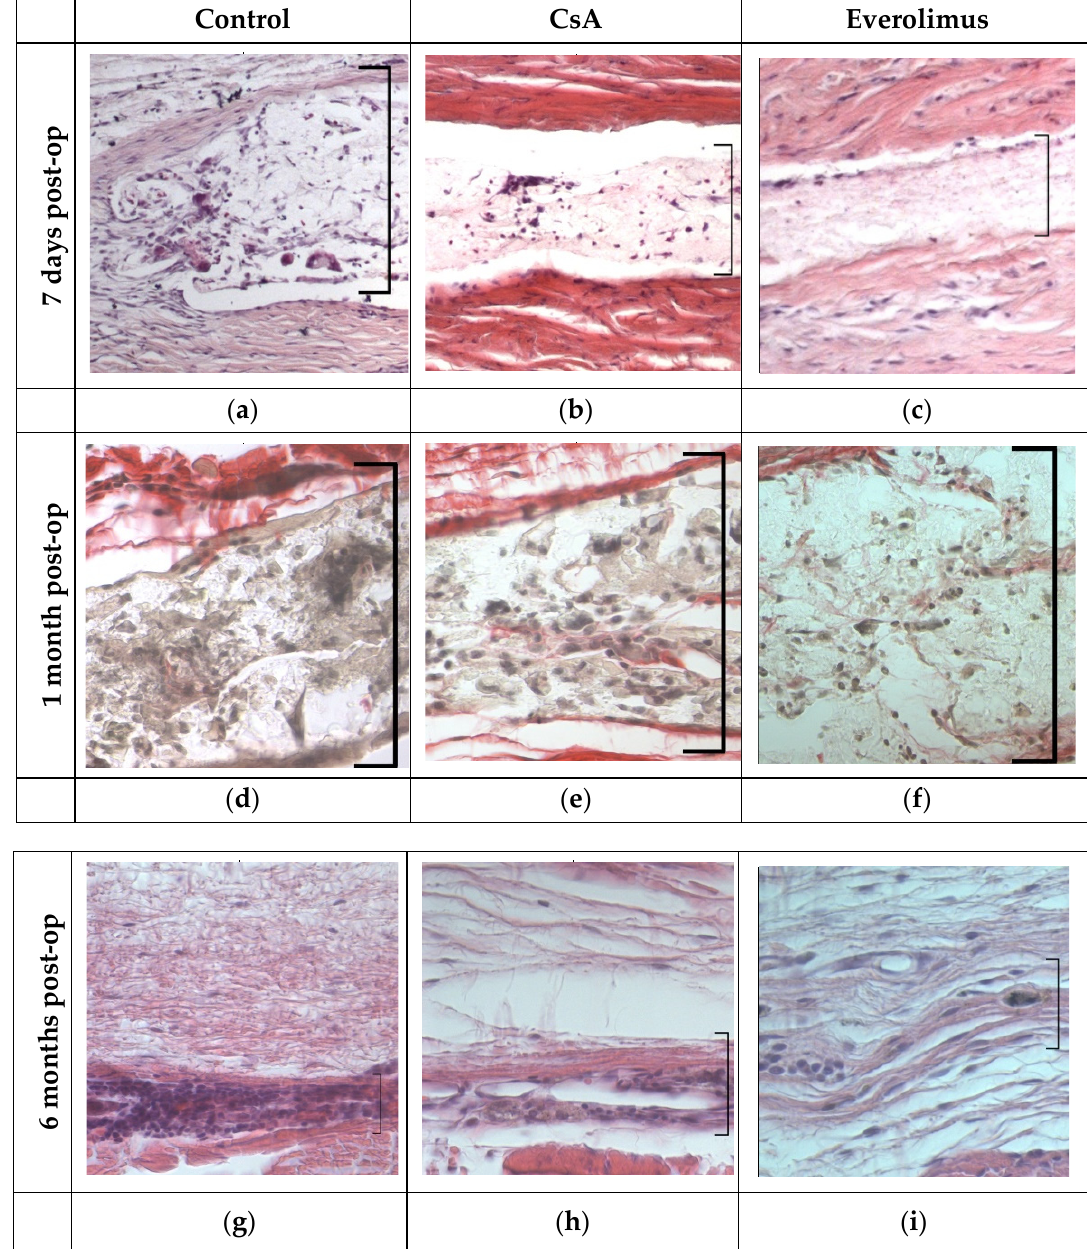
Figure 13. Histological sections of surgery area with implants. Square bracket indicates the implant area. ( a – c ). Stain: hematoxylin/eosin. Magnification × 100. ( d – f ). Stain: hematoxylin/picrosirius red. Magnification ×400. ( g – i ). Stain: hematoxylin/eosin. Magnification ×400.